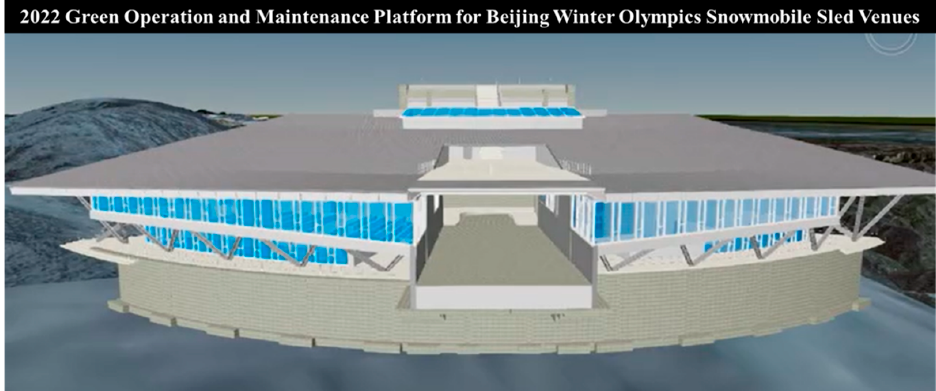
Figure 10. Green O&M platform for Beijing Winter Olympics snowmobile sled venues.